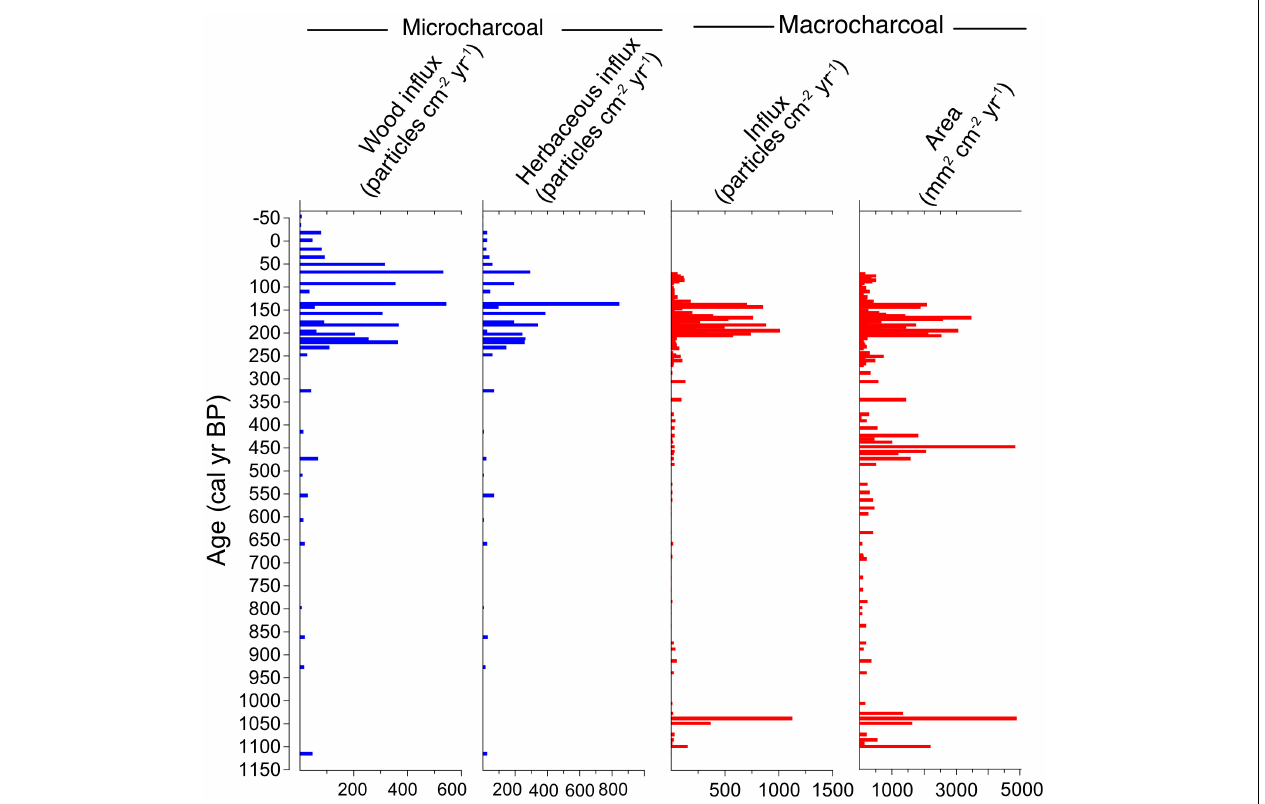
FIGURE 5 | Microcharcoal influx (particles cm − 2 yr − 1 ), macrocharcoal influx (particles cm − 2 yr − 1 ), and macrocharcoal area (mm 2 cm − 2 yr − 1 ) from the Namonte sediment core, southwest Madagascar.